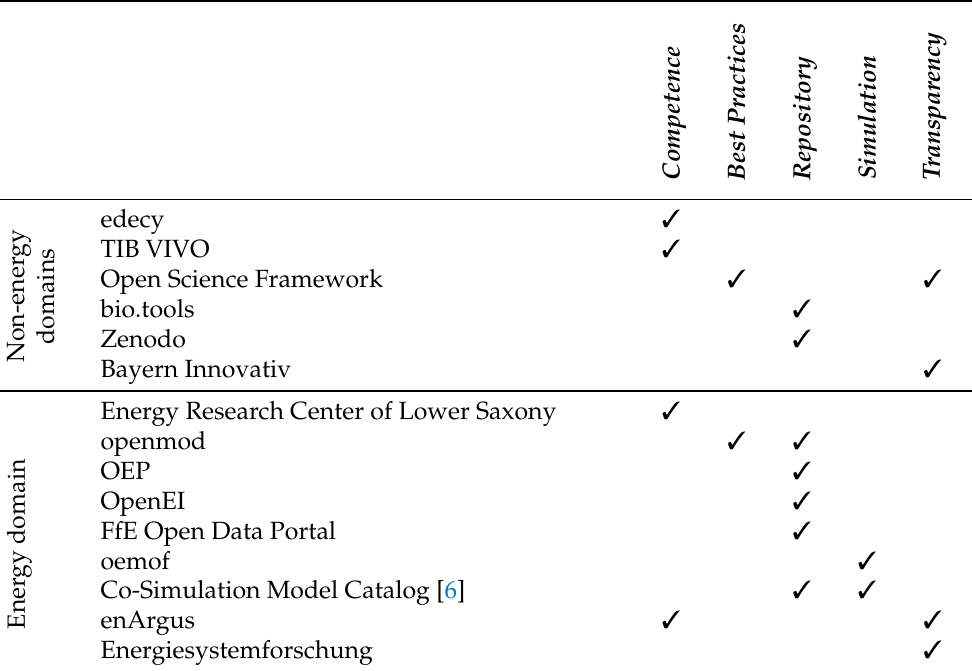
Table 1. Overview of related